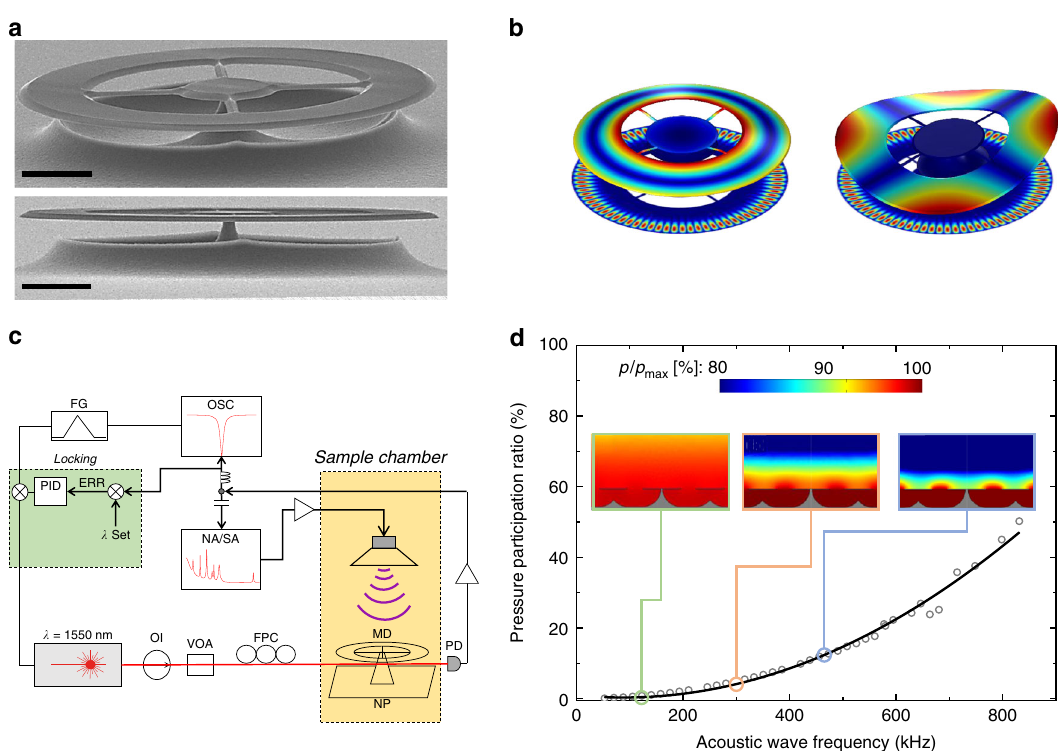
Fig. 2 Device architecture and experimental schematic. a Scanning electron micrograph of a similar microdisk to that used in this study. The microdisk is an optical cavity which is evanescently coupled to a tapered optical fi bre. The scale bar corresponds to 20 μ m. b Finite-element simulations of the modeshapes of two typical mechanical modes of the microdisk (left: second-order fl apping mode, right: crown mode). c The phase sensitive and thermally stabilised experimental setup used to characterise the sensor. NP nanopositioner, MD microdisk, PD photodetector, FPC fi bre polarization controller, VOA variable optical attenuator, OI optical isolator, FG function generator, OSC digital oscilloscope, NA network analyser, SA spectrum analyser. d The simulated pressure participation ratio, i.e., the fraction of the total acoustic pressure acting on the mechanical structure, for a number of frequencies. The insets display the pressure distribution at 105, 281 and 421 kHz, respectively; while p / p max is the ratio of the pressure to the pressure at the antinodes of